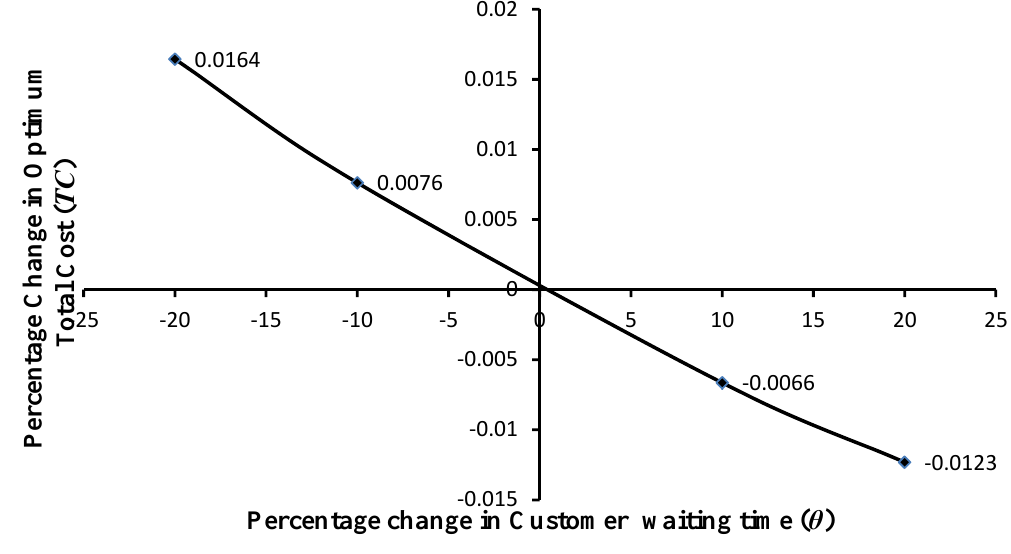
Fig. 5. Total Cost ( TC ) versus Customer waiting time ( θ